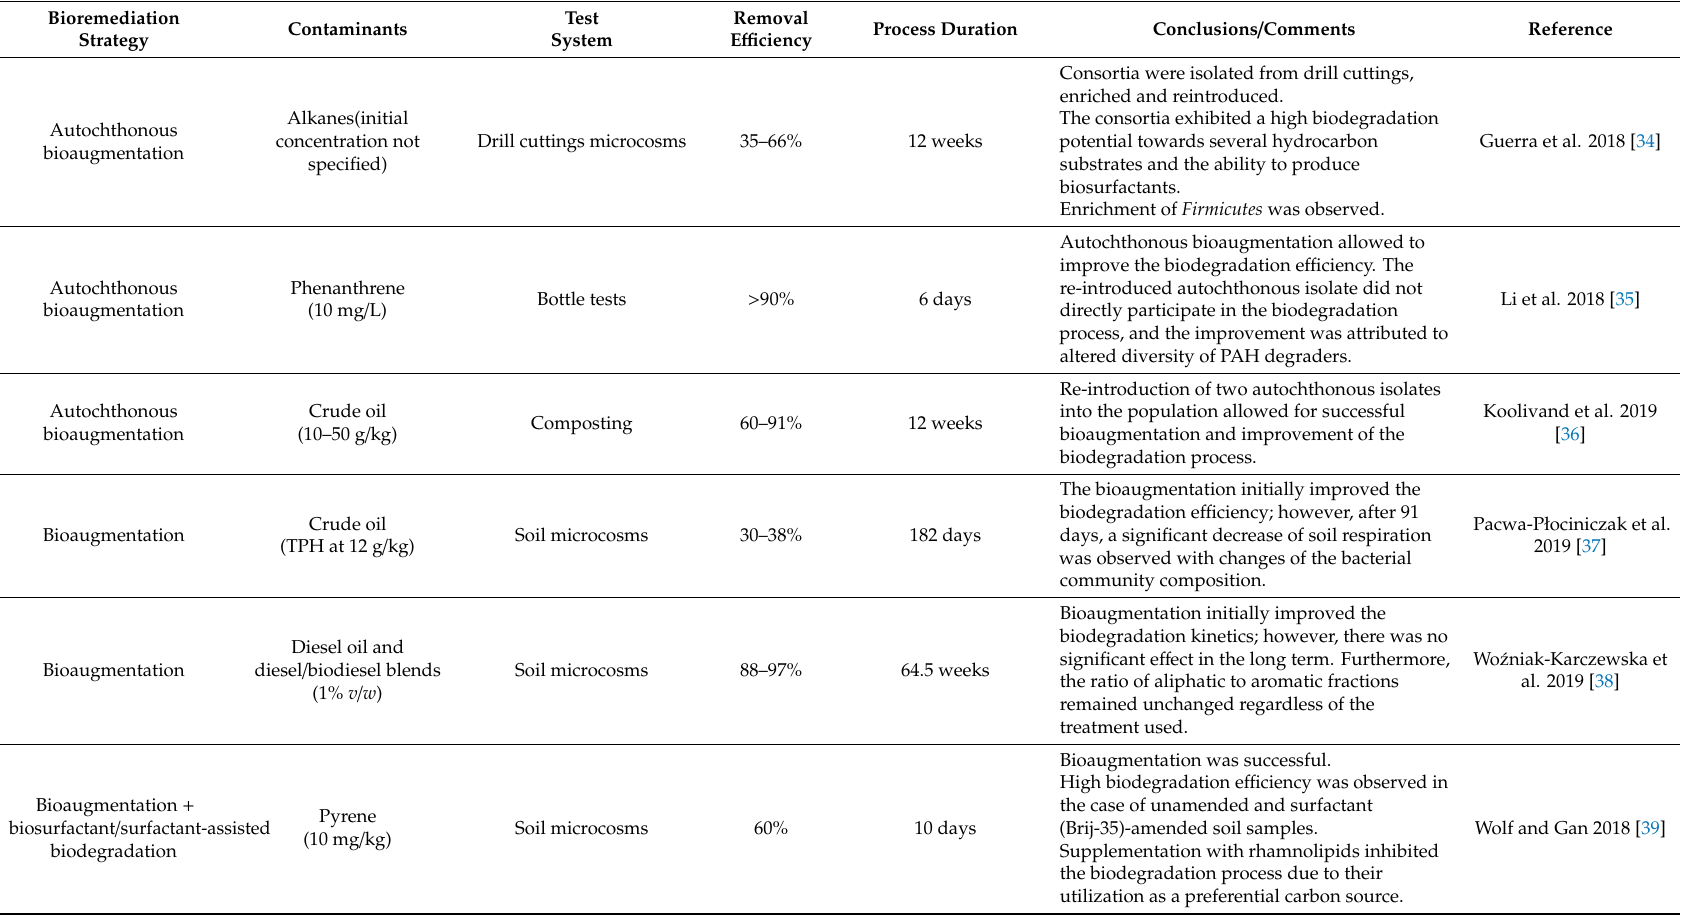
Table 1. Overview of recent studies regarding hydrocarbon biodegradation